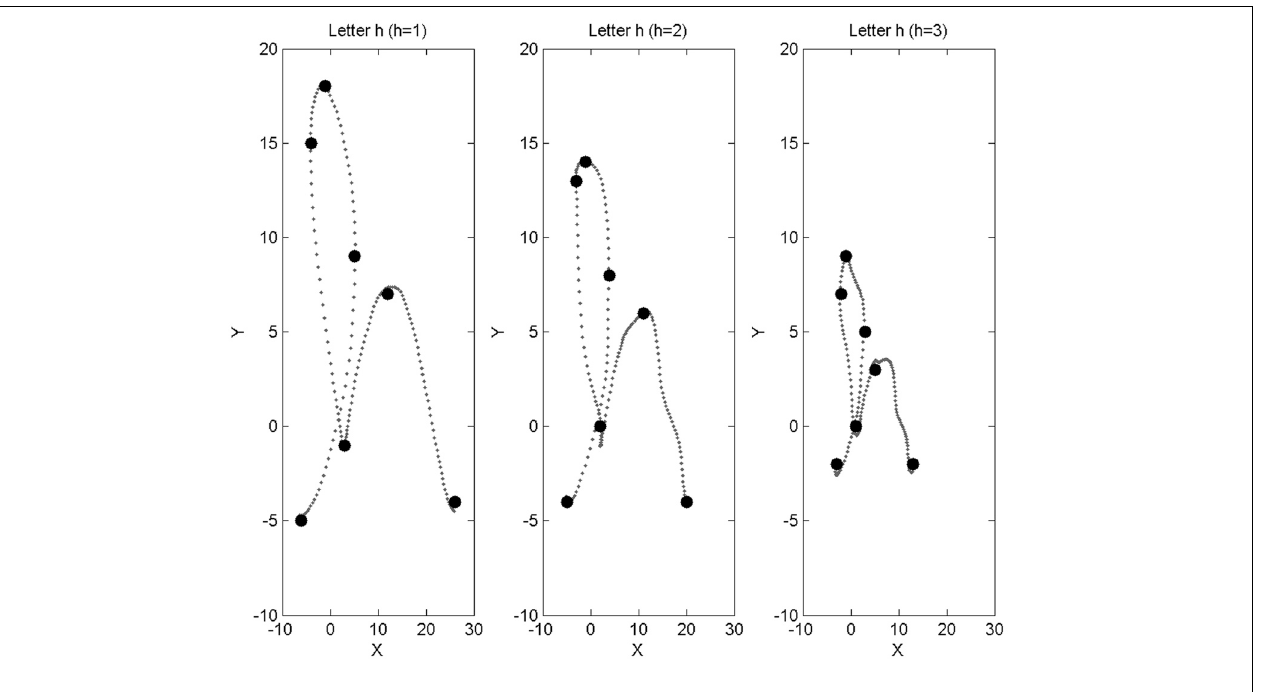
FIGURE 14 | Left: example trajectory for the letter “h,” taken from our database, and associated with base disability level (healthy subject). Middle, right : trajectories obtained from the “h”